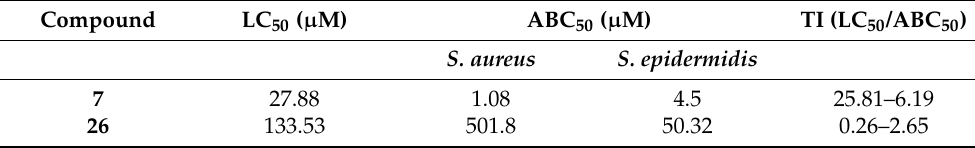
Table 5. LC 50 , ABC 50 , and TI of compounds 7 and 26